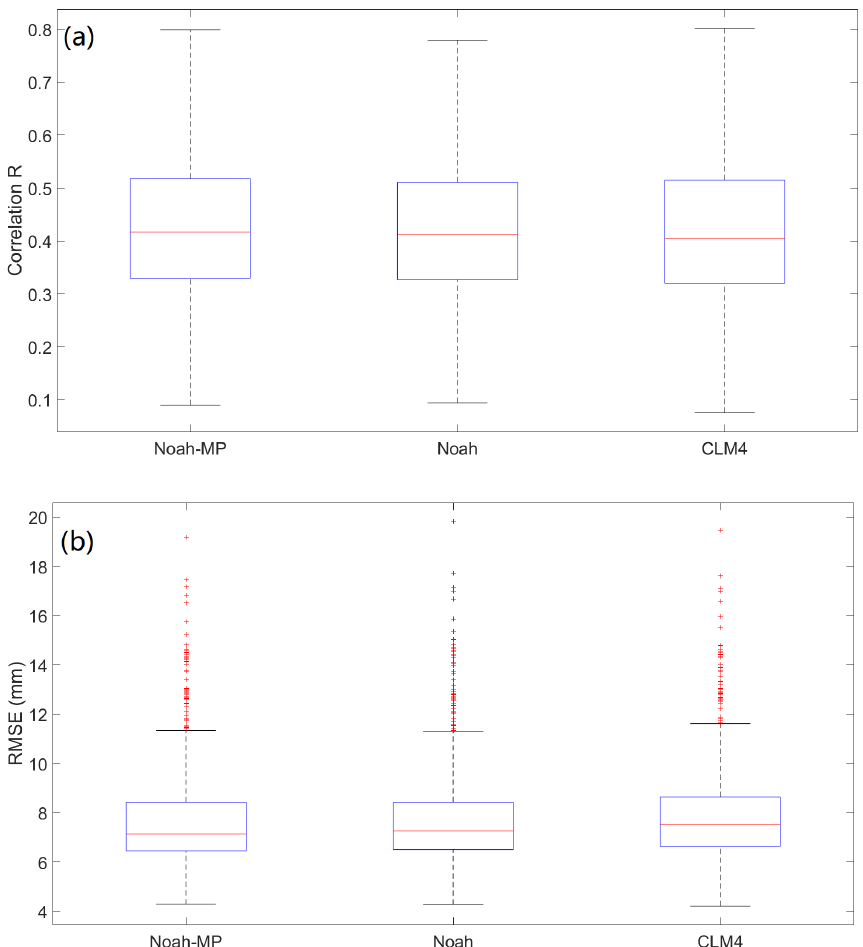
Figure 6. Boxplots of rainfall evaluation results of (a) R and (b) RMSE: minimum; maximum; 0.25, 0.50, and 0.75 percentiles; and outliers (red